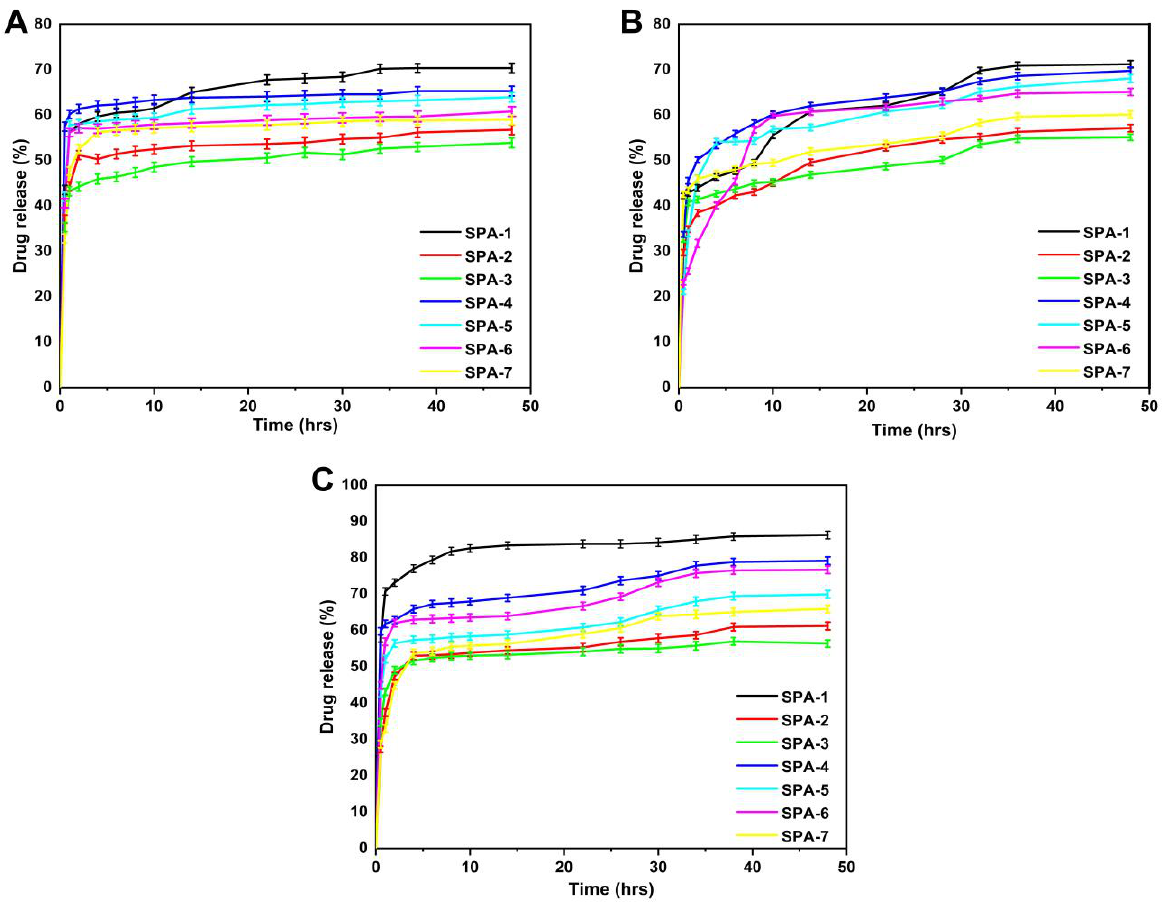
Figure 7. Drug release curve of a hydrogel membrane at pH of 1.2 ( A ), pH of 5.5 ( B ), and pH of 7.4 ( C